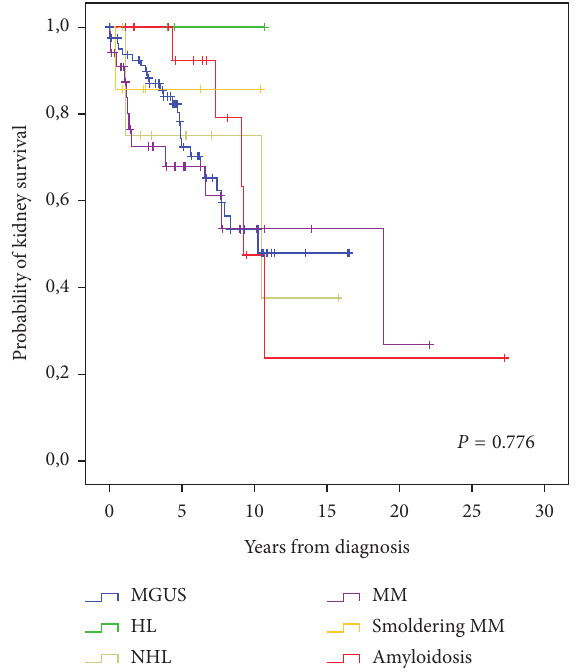
Figure 3: Death-censored kidney survival (CKD 5 or dialysis) according to the diagnosis of monoclonal